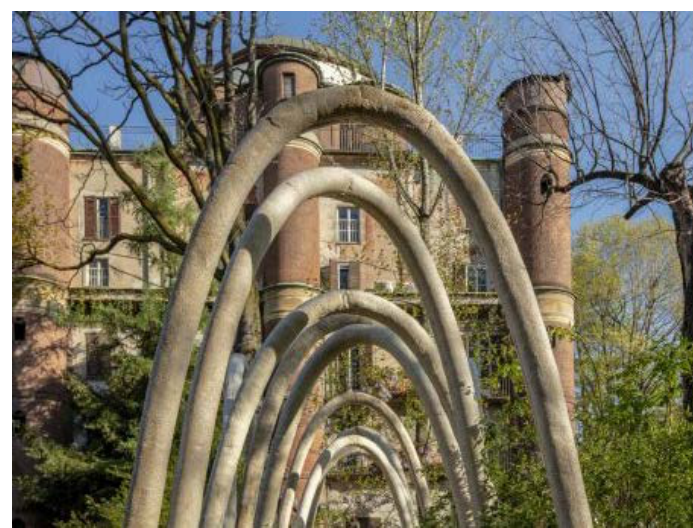
Figure 13 The Circular Garden-2019 (Url-17).